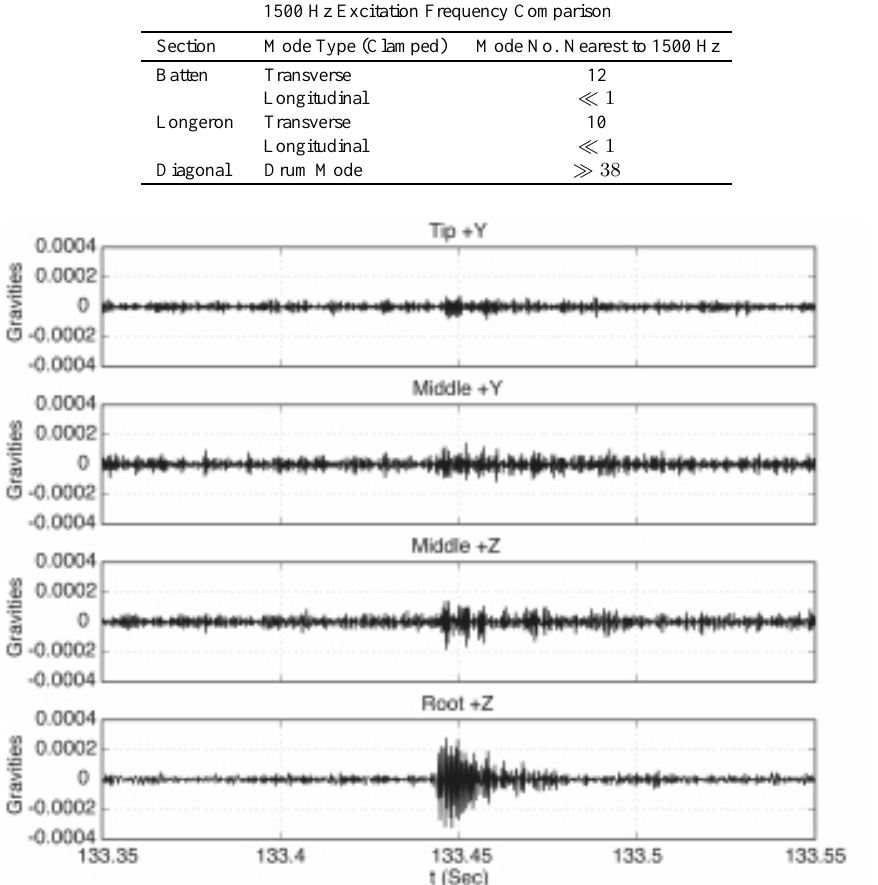
Fig. 5. Response Dispersion of Event 1 along the Boom (Band-pass Filtered between 1.1 and 2